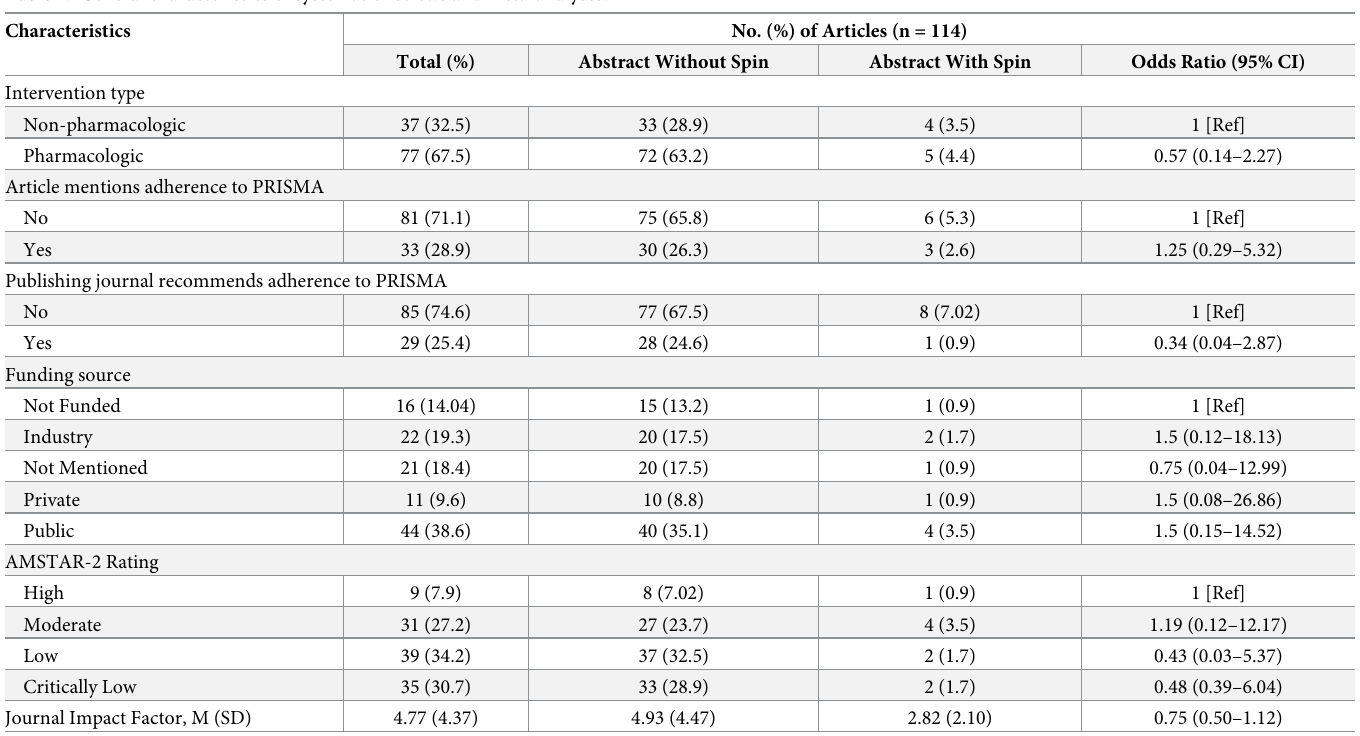
Table 2. General characteristics of systematic reviews and